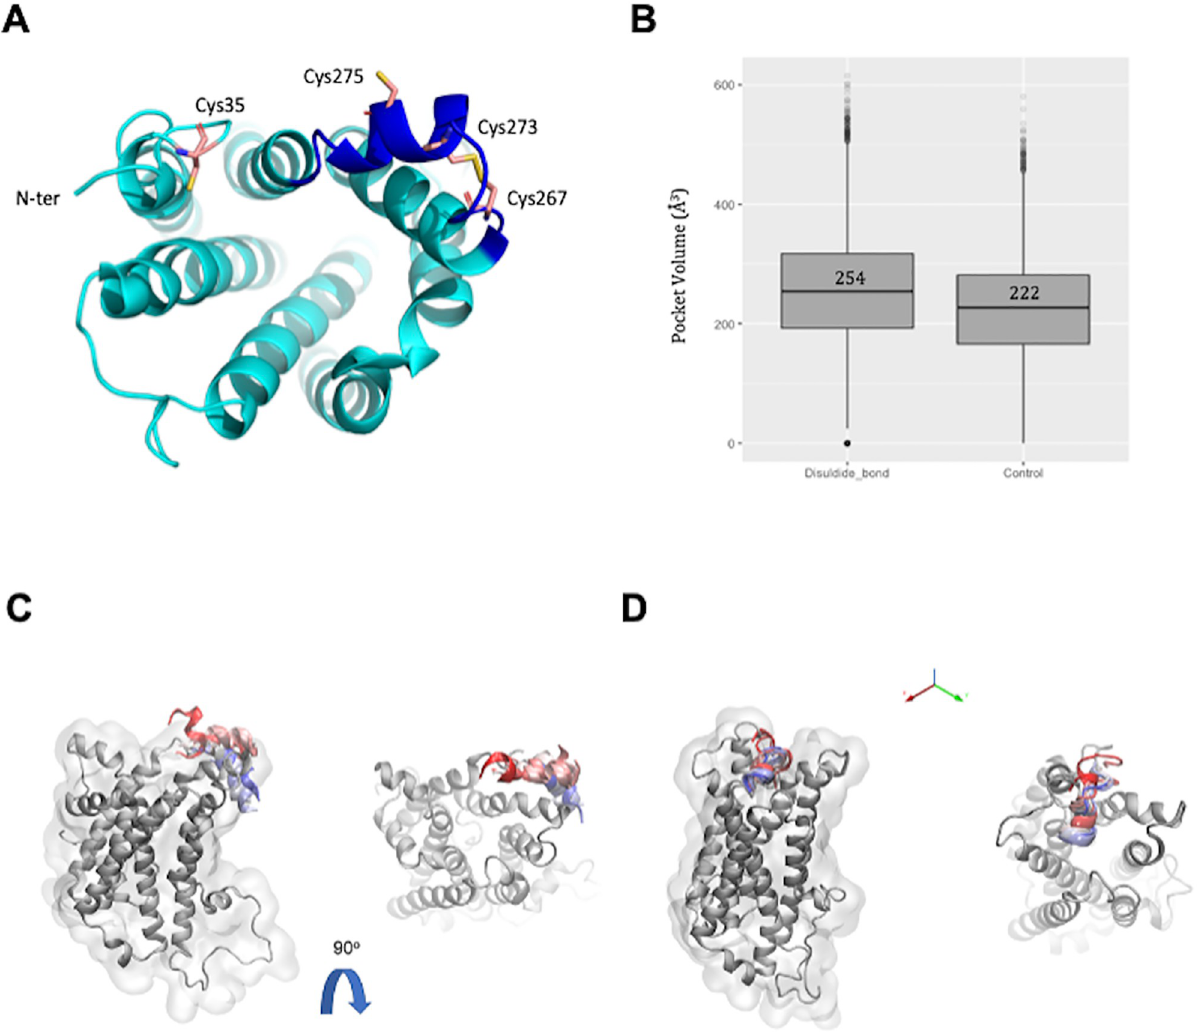
Fig 4. Role of the Cys35-Cys275 disulfide bridge on the MC1R structure dynamics. ( A ) MC1R structure model is shown as cartoon colored in cyan and four critical cysteine residues are represented as sticks, colored in pink. The extracellular loop 3 is highlighted in dark blue. The disulfide bridge formed by residues 267 and 273 was derived from the MC4R structure used as template for comparative modelling of MC1R . Cys35 and Cys275 could be a potential pair for a second disulfide bridge on the protein structure. ( B ) Root Mean Square fluctuation (RMSF) for MC1R residues in presence of the disulfide bond (Cys35-Cys275), in its absence (Cys35) and upon Cys35Tyr mutation. ( C ) MC1R binding site volume variation along the MD simulation trajectories. The plot accounts for both MD replicas of MC1R model in presence of the disulfide bridge (bridge) and in absence of the disulfide bridge (control). Median values are indicated on the plot. ( D ) MC1R conformational changes observed during MD simulations. Representative structures for each system are displayed as a cartoon, colored in cyan. The N-ter first 15 residues are colored in red and the mutation site is indicated as a red sphere. The binding pocket is represented as surface, colored in light orange. When MC1R model bears the Cys35-Cys275 disulfide bond (top), the accessibility of the binding pocket is maintained, with no interference of the N-terminal loop; while in the absence of the bond (middle), the N-terminal loop of MC1R is maintained at the edge of the binding cavity area, interfering with its accessibility. Finally, upon mutation to tyrosine (bottom), the structure suffers an important conformational change that decreases dramatically the pocket volume, and therefore, its capacity to welcome